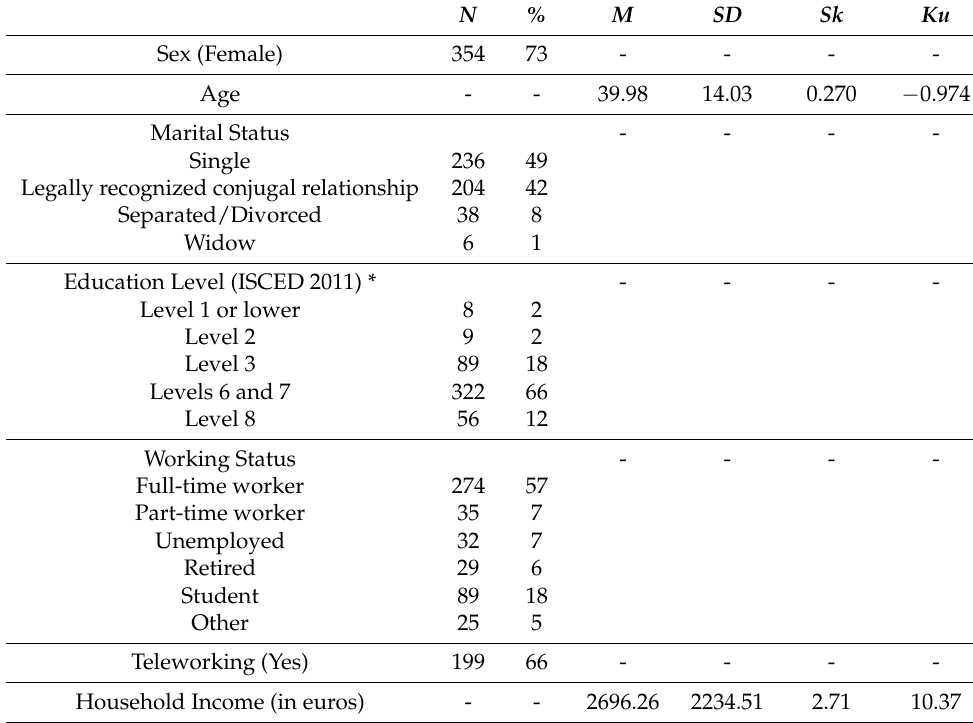
Table 1. Study participants